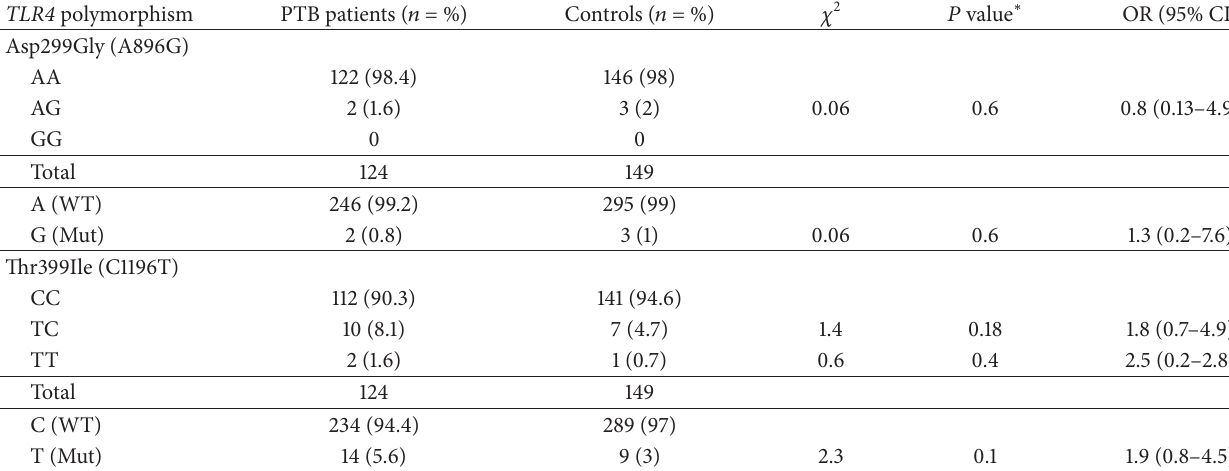
Table 3: TLR4 SNPs allele and genotype frequencies in patients and controls.